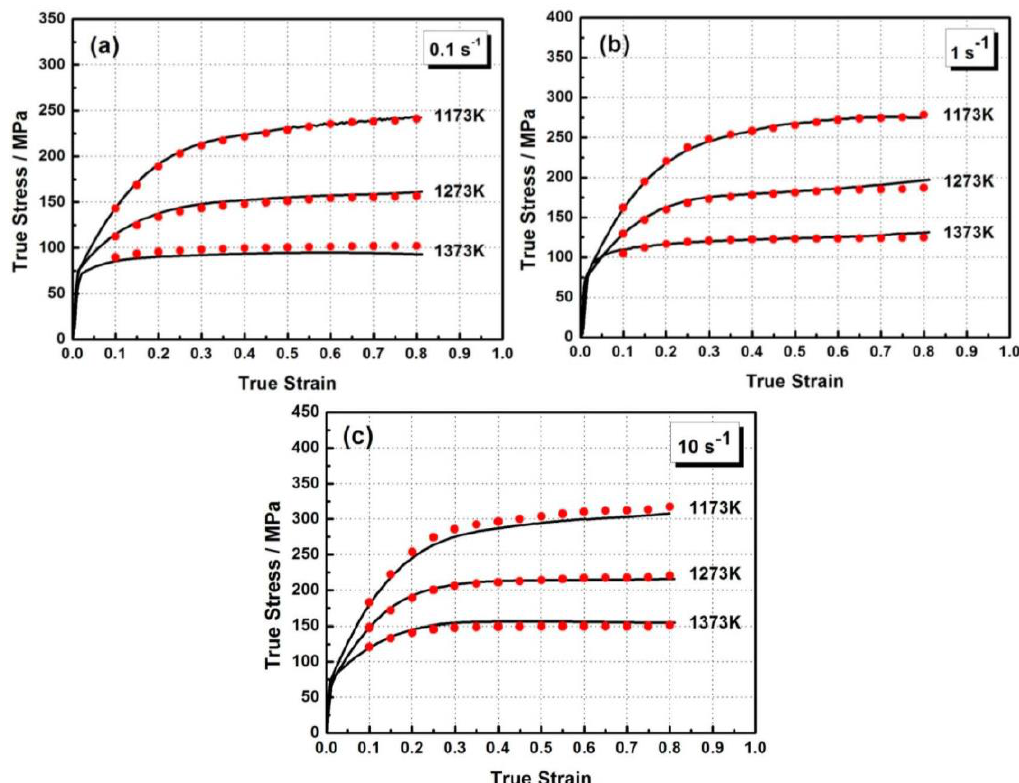
Figure 5. The comparisons between the experimental curves (lines) and predicted values (circles) of the studied steel under different deformation temperatures with strain rates ( a ) 0.1 s −1 ; ( b ) 1 s −1 ; and ( c ) 10 s −1